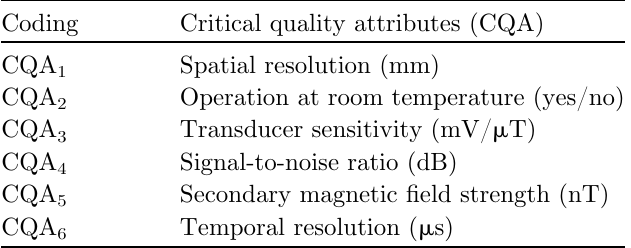
Table 2. CQA associated with the measurement system for biomedical